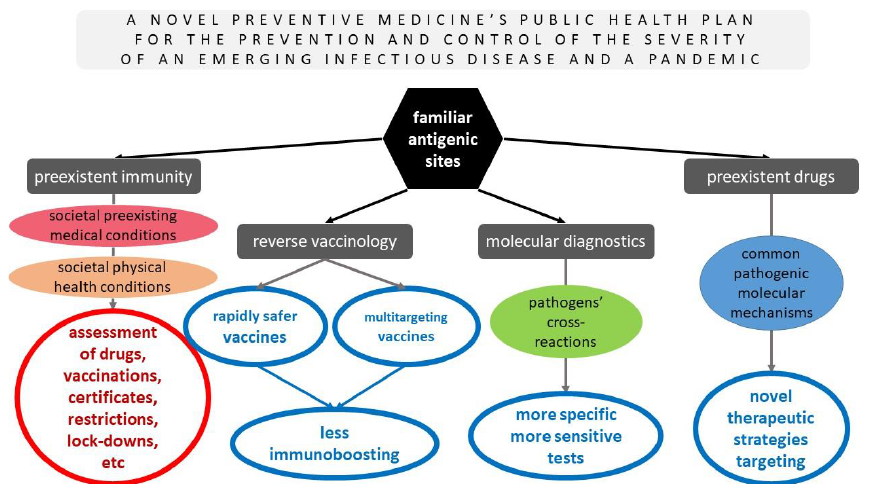
Figure 2. A novel preventive medicine’s public health plan for the prevention and management of the severity of future (re)emerging infectious diseases based on the hypothesis of the already known pathogens’ antigenic sites and their advantages.